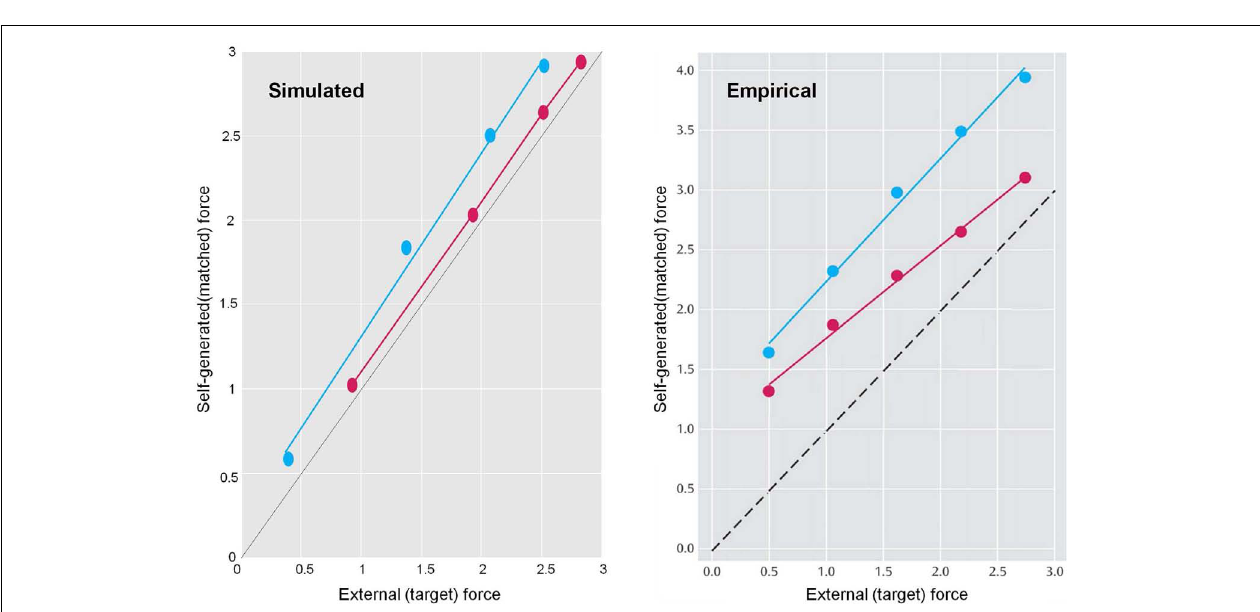
increasing the precision of prediction errors at higher levels of the hierarchy. This resulted in a more veridical perception of internally generated force (red circles). Right panel: the empirical data from the force-matching task, with normal subjects’ forces in blue, and schizophrenics’ forces in red reproduced from Shergill et al.